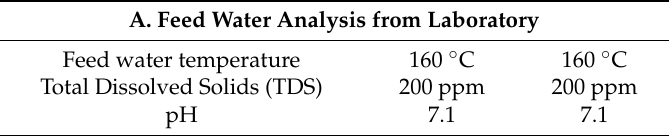
Table 4. Feed water analysis data.